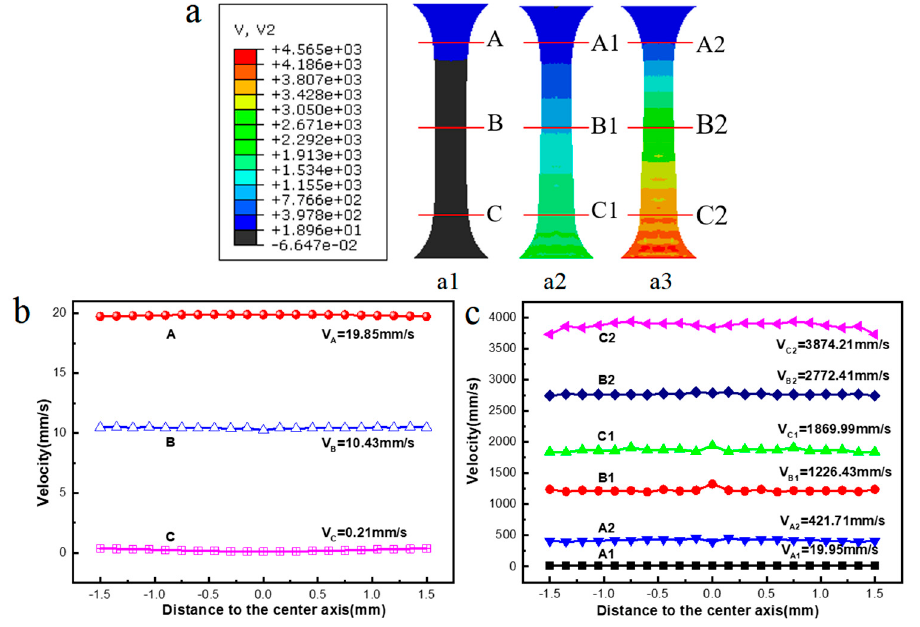
Figure 11. The simulated velocity distribution under three ultrasonic amplitudes by assuming a temperature of 370 ◦ C: ( a1 ) 0 µ m; ( a2 ) 15 µ m; and ( a3 ) 30 µ m. ( b , c ) present the corresponding speed distribution at various positions.